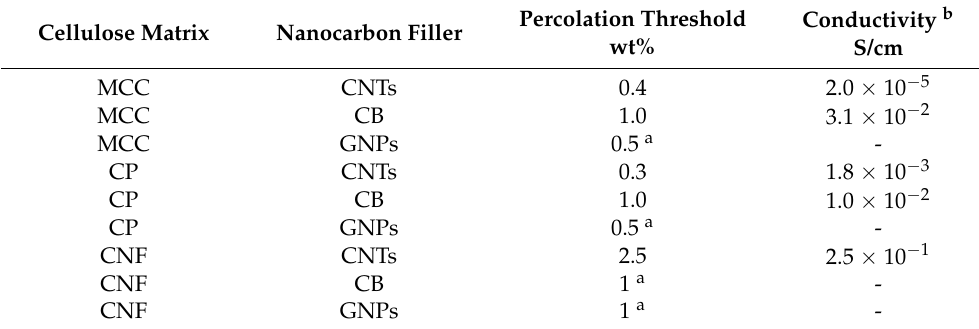
Table 2. Electrical percolation threshold values (wt%) and conductivity at the percolation threshold of nanocomposite films from all nine cellulose/nanocarbon